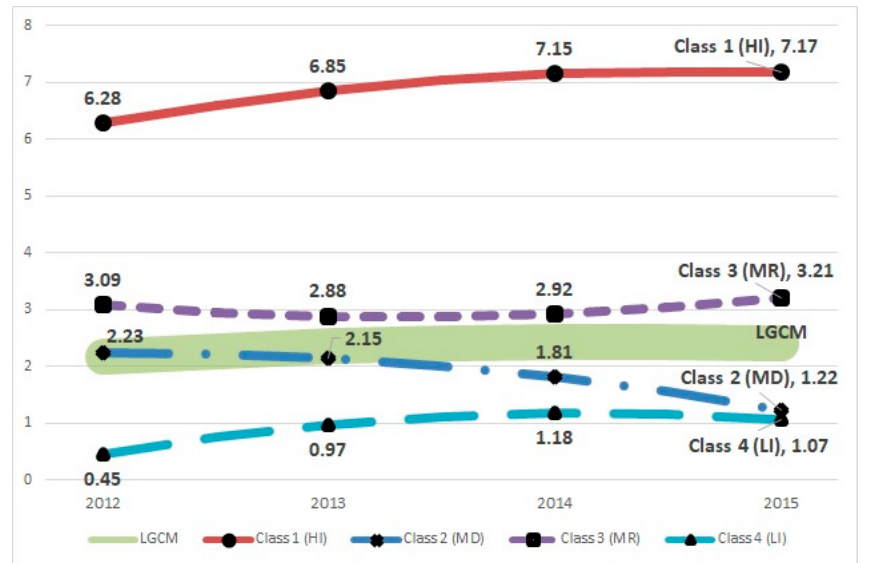
Figure 3. GMM results. Note(s) : HI = High-Increasing class; MD = Medium-Decreasing class; MR = Medium-Recovering class; LI = Low-Increasing class; LGCM = Overall latent growth curve model. Table 5. Differences in demographic characteristics between